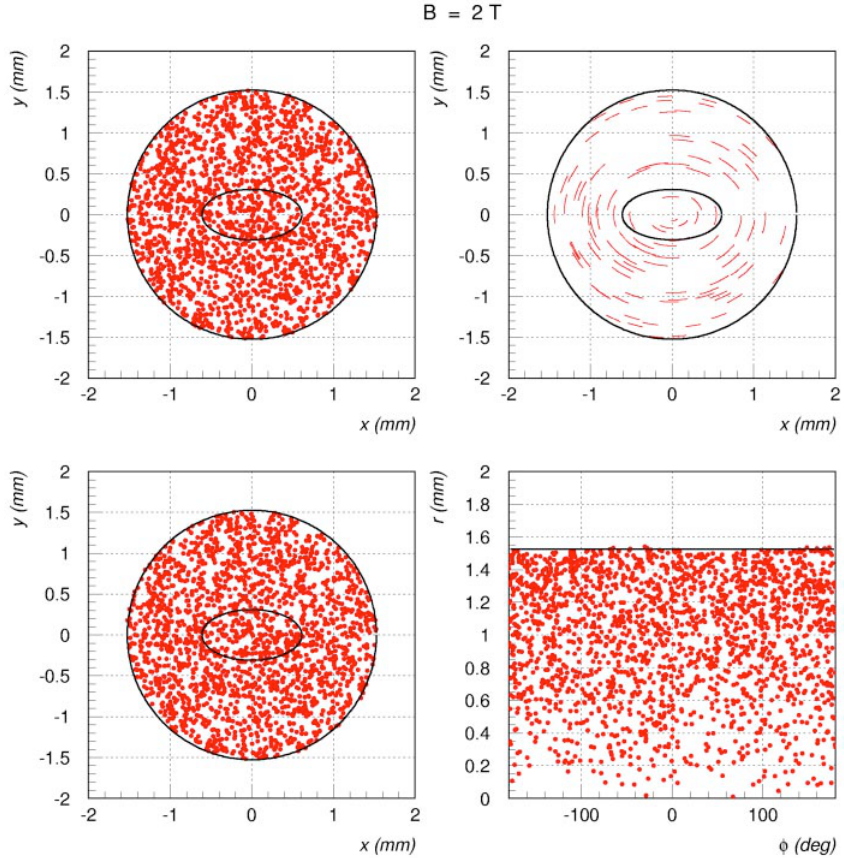
FIG. 4. (Color) Wide electron beam distortion due to narrow (cid:197) (cid:112)